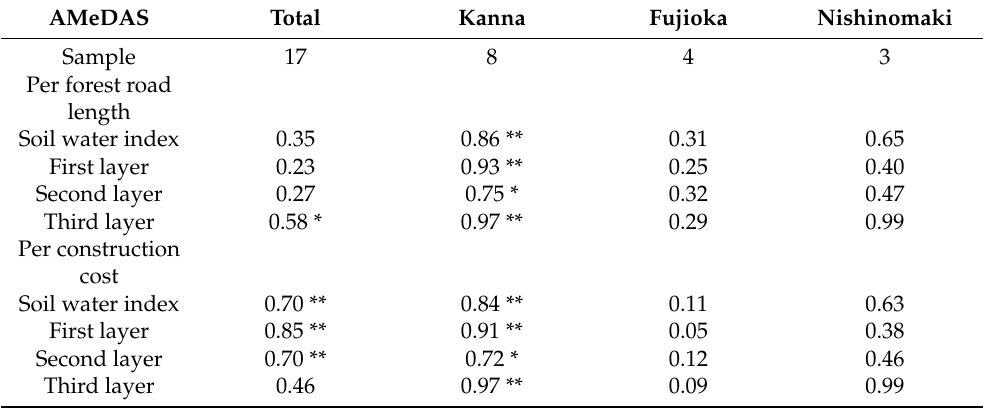
Table 2. Correlation coefficient between the maximum annual return period and recovery cost per forest road length or construction